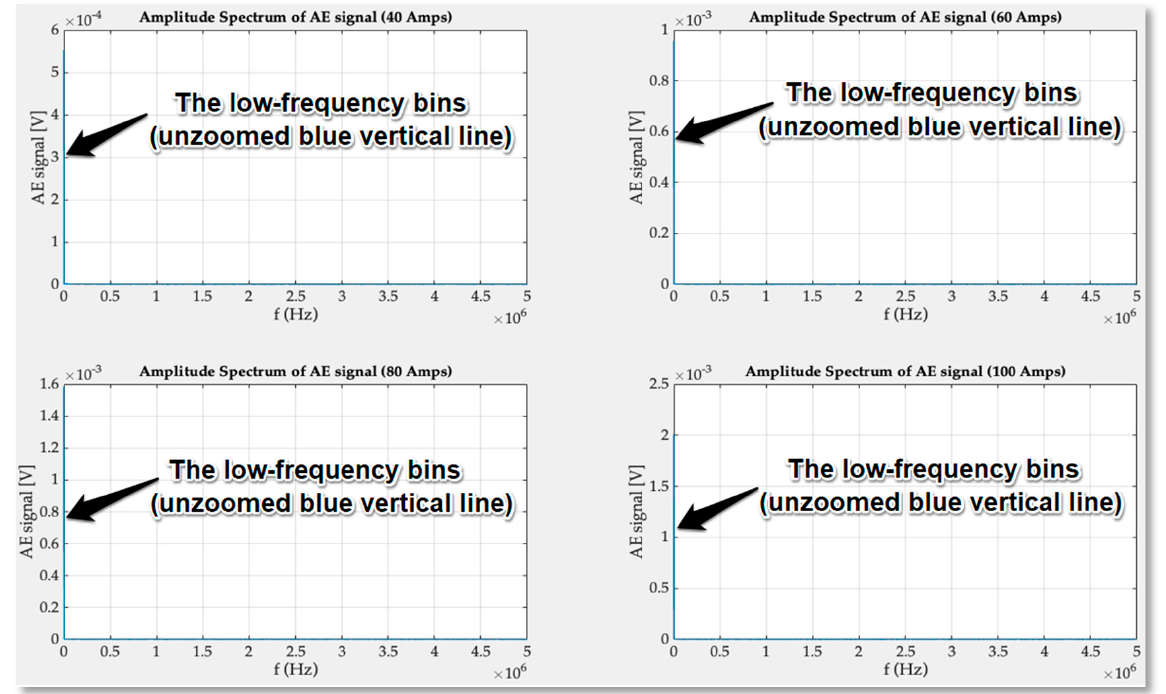
Figure 12. Wideband frequency spectrum of acoustic emission signal obtained for 40, 60, 80 and 100 amperes current.